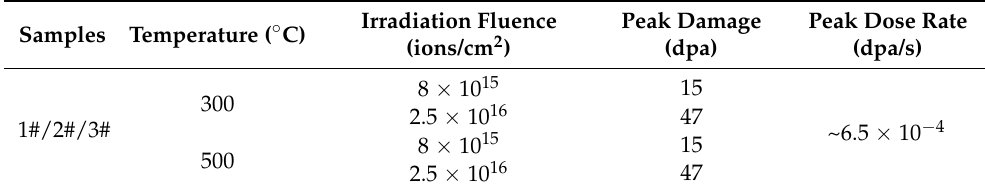
Table 2. The irradiation conditions of 3 MeV Fe 11+ for the three HEAs, including temperature, fluence, and peak displacement damage, and peak dose rate calculated by SRIM